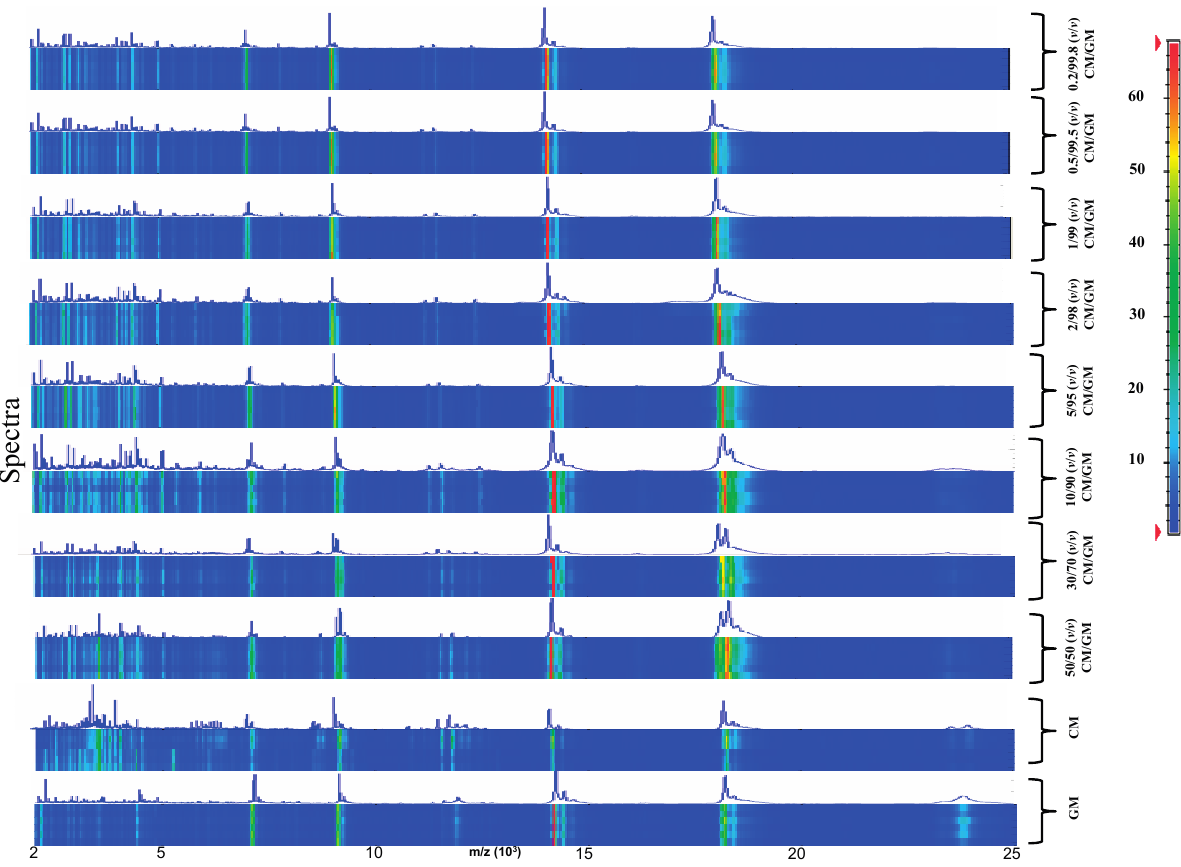
Figure 4. Pseudo-gel like image and MALDI-TOF MS spectra of the simulated adulteration of GM by CM.